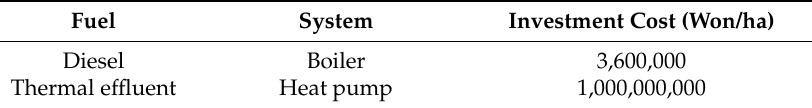
Figure 9. Percentage of each system in investment costs. Table 7. Investment costs of each energy system.